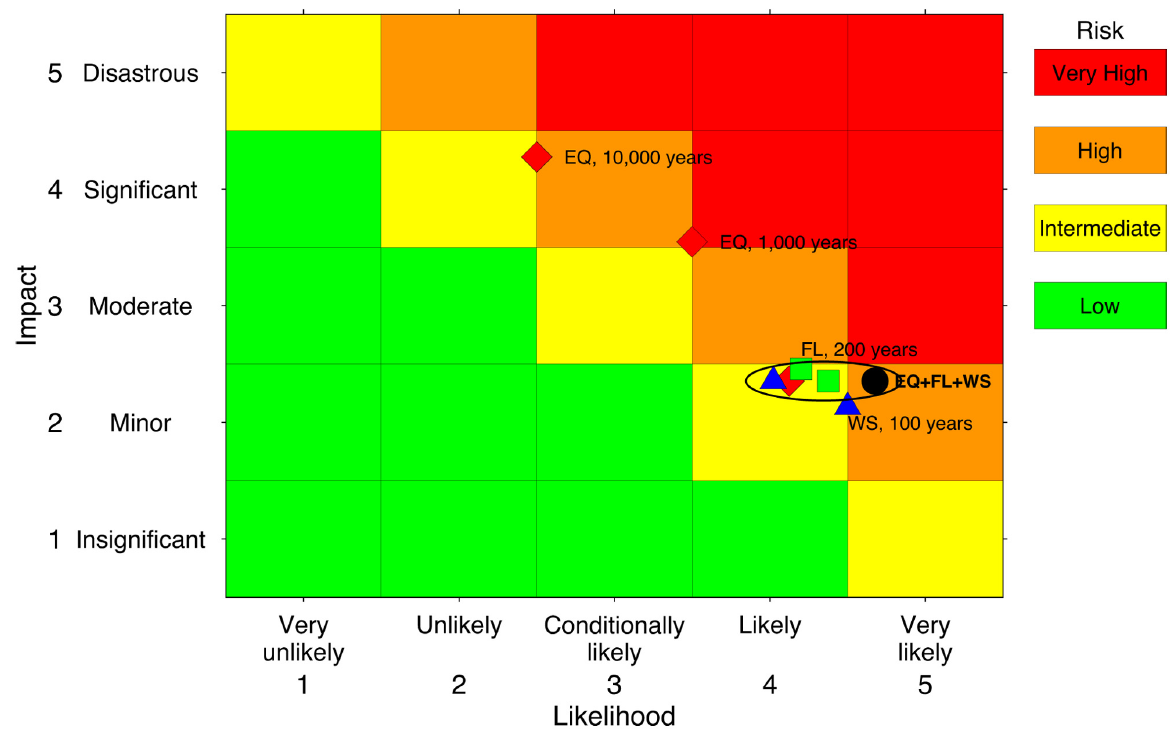
Figure 2. Risk matrix (exploiting the values presented in Figure 1) showing how combining the risk associated with individual perils (EQ - earthquake, FL - flood, WS - windstorm) can lead to a significantly higher probability of exceeding a given level of loss (EQ+FL+WS). The individual and combined risk estimates outlined by the ellipse correspond to the annual exceedance of losses of ⇔ 100 million, hence why they are all along the same Impact row. The ranges for the different classifications are presented in Table 1. The color scheme is derived from that used by BBK